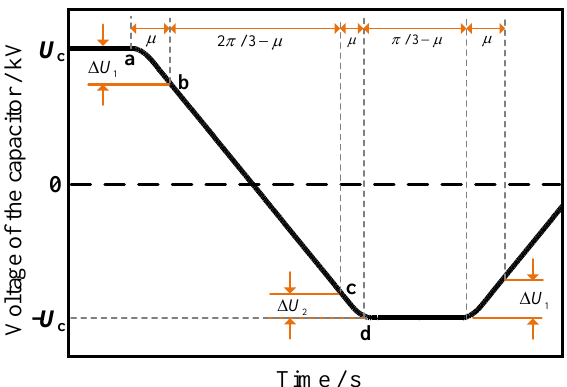
Figure 3. Voltage waveforms of the commutation capacitors.